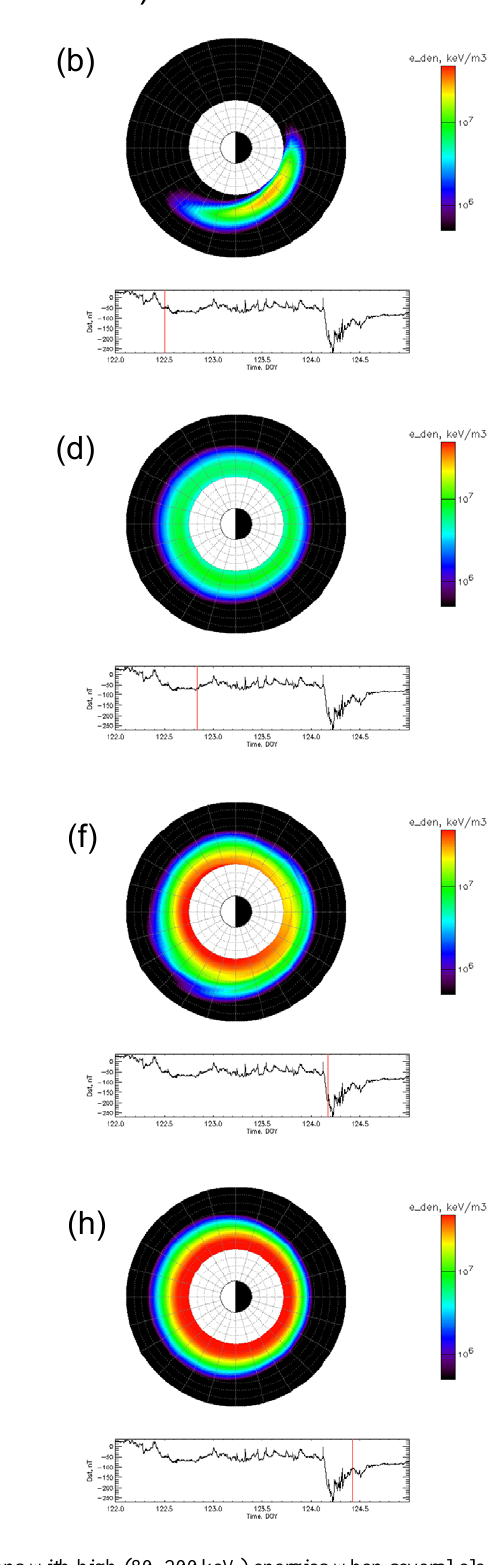
Fig. 9. Calculated energy density maps in the equatorial plane for protons with high (80–200keV) energies when several electromagnetic pulses were activated at the substorm onsets during the modelled period of 2–4 May